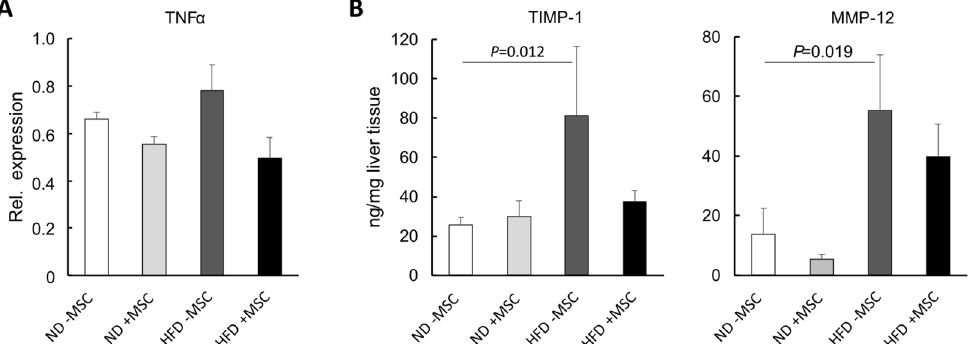
Figure 7. MSC treatment decreases molecular markers of inflammation in livers of high-fat-diet-fed mice:( A ) quantification of TNF α mRNA abundance by sqRT-PCR; expression was normalized to the expression of hypoxanthine phosphoribosyltransferase (Hprt1) used as a housekeeping gene; values are means ± SEM from 3 (ND − MSC), 4 (ND + MSC), 5 (HFD − MSC) and 6 (HFD + MSC) animals per group; ( B ) TIMP-1 and MMP-12 were quantified by Multiplex analysis; values are means ± SEM from 4, 4 (ND − MSC), 4, 3 (ND + MSC), 5, 6 (HFD − MSC) and 7, 7 (HFD + MSC) animals per group for the determination of TIMP-1 and MMP-12, respectively; values are means ± SEM; statistics: LSD post hoc test after Johnson transformation.